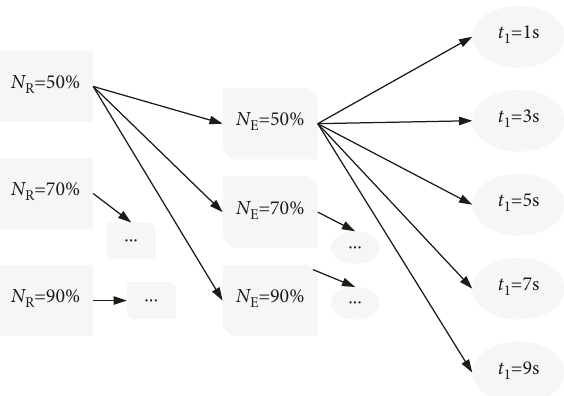
Figure 10: Arrangement of the engaging parameters.